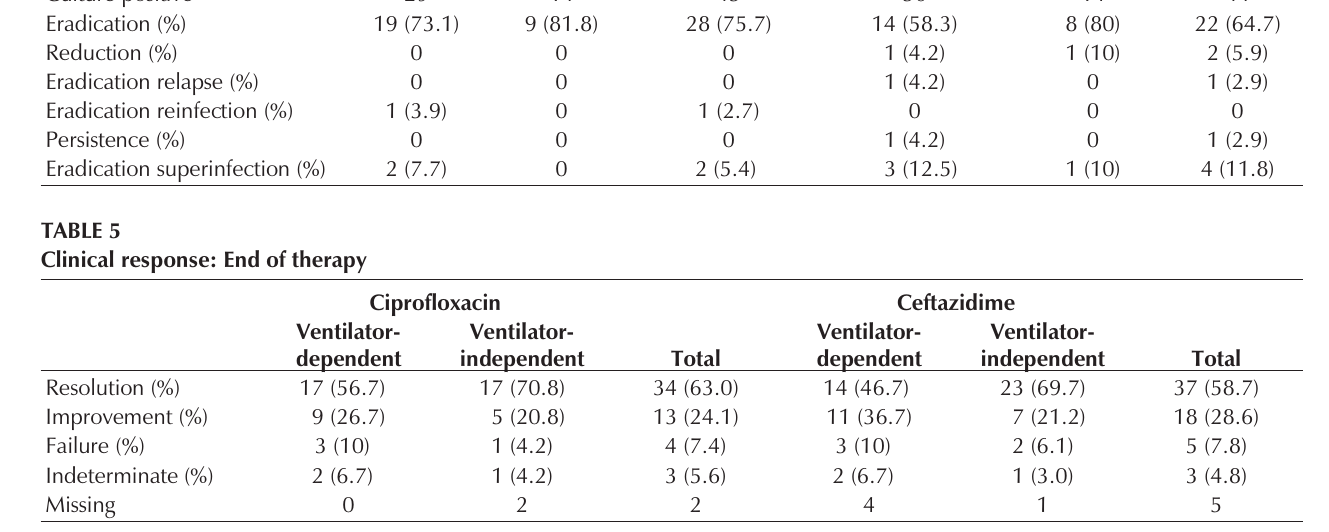
Color profile: Disabled Composite Default